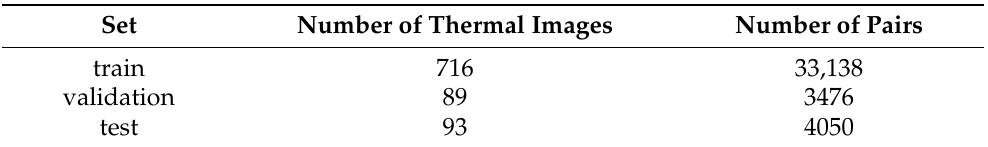
Table 4. We divided the data into three parts according to the ratio of 8:1:1, namely training, validation, and test